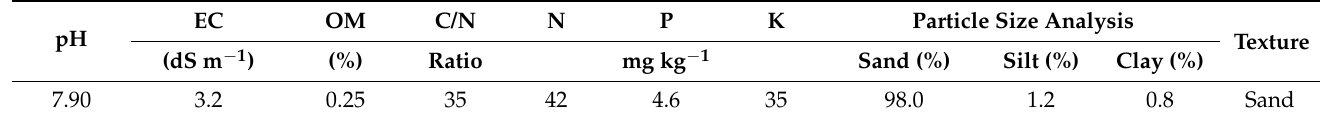
Table 1. Soil properties of isolated strain S. thinghirensis strain